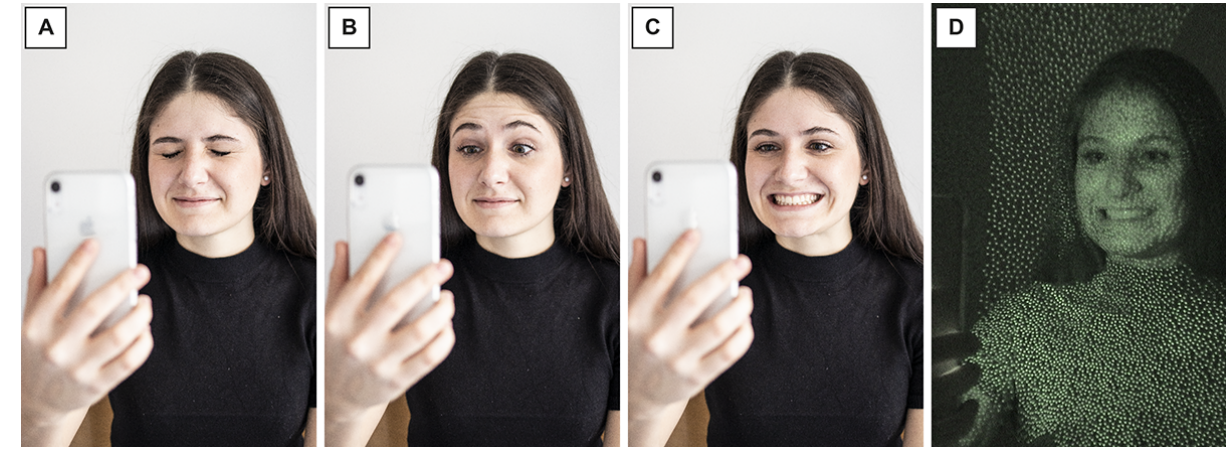
Figure 4. Test sequence using the Digital Facial Index (DFI) tracker app, with conventional photos during which the user performed 3 facial movements during a defined measurement time window, including (A) “close your eyes,” (B) “raise your eyebrows,” and (C) “pull up the corners of your mouth,” and (D) an infrared photograph that shows part of the 30,000 points thrown at the user by the smartphone’s dot projector to capture depth data of the face. The depicted author provided written informed consent for her photos to be used for this